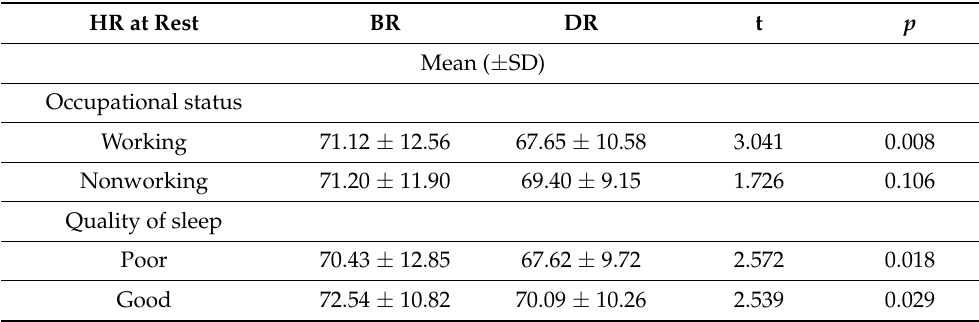
Table 6. Heart Rate at rest of the study participants according to the occupational status and quality of sleep. Values before (BR) and during (DR) Ramadan.